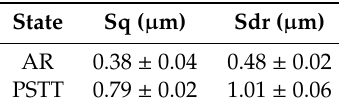
Table 6. Quantitative comparison of the surface of the AR material and that of the PSTT material after 7%